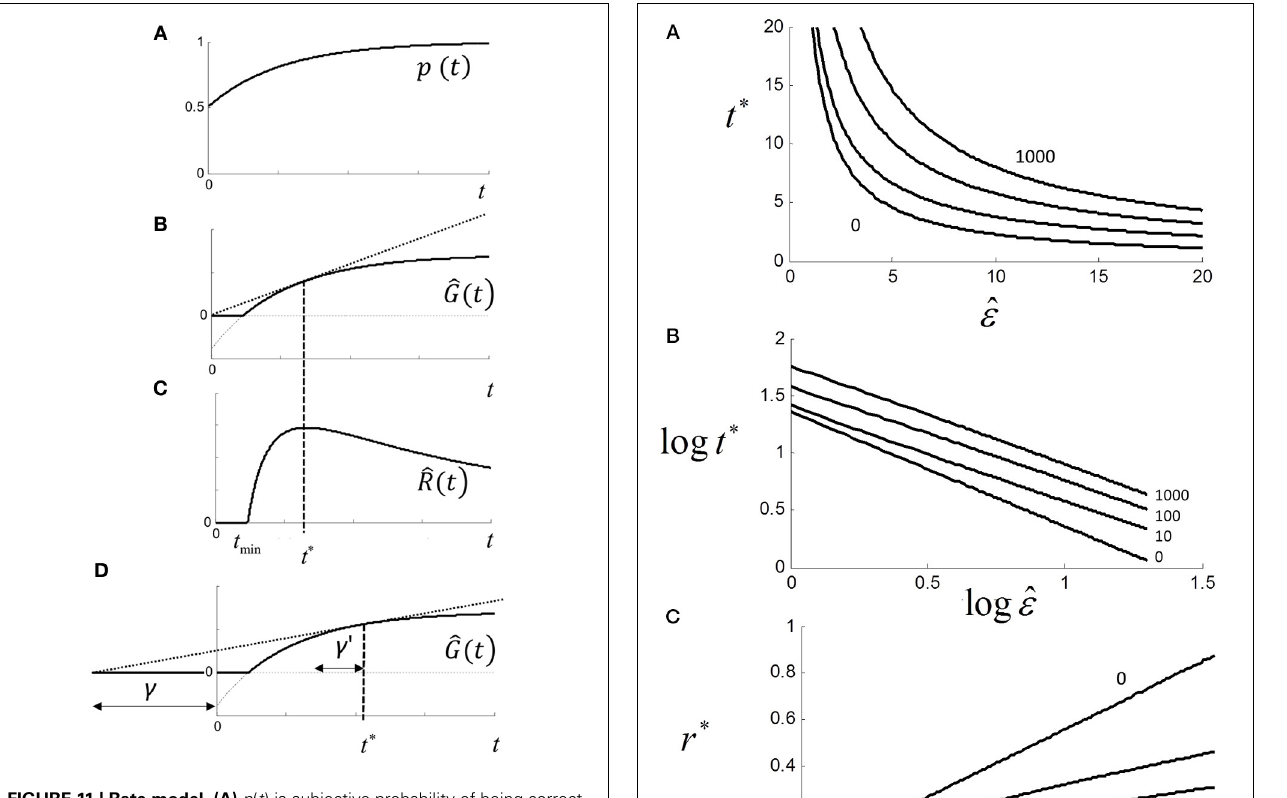
ˆ ˆ G ˆ ε ( t ) = G ( ˆ ε t ), we note